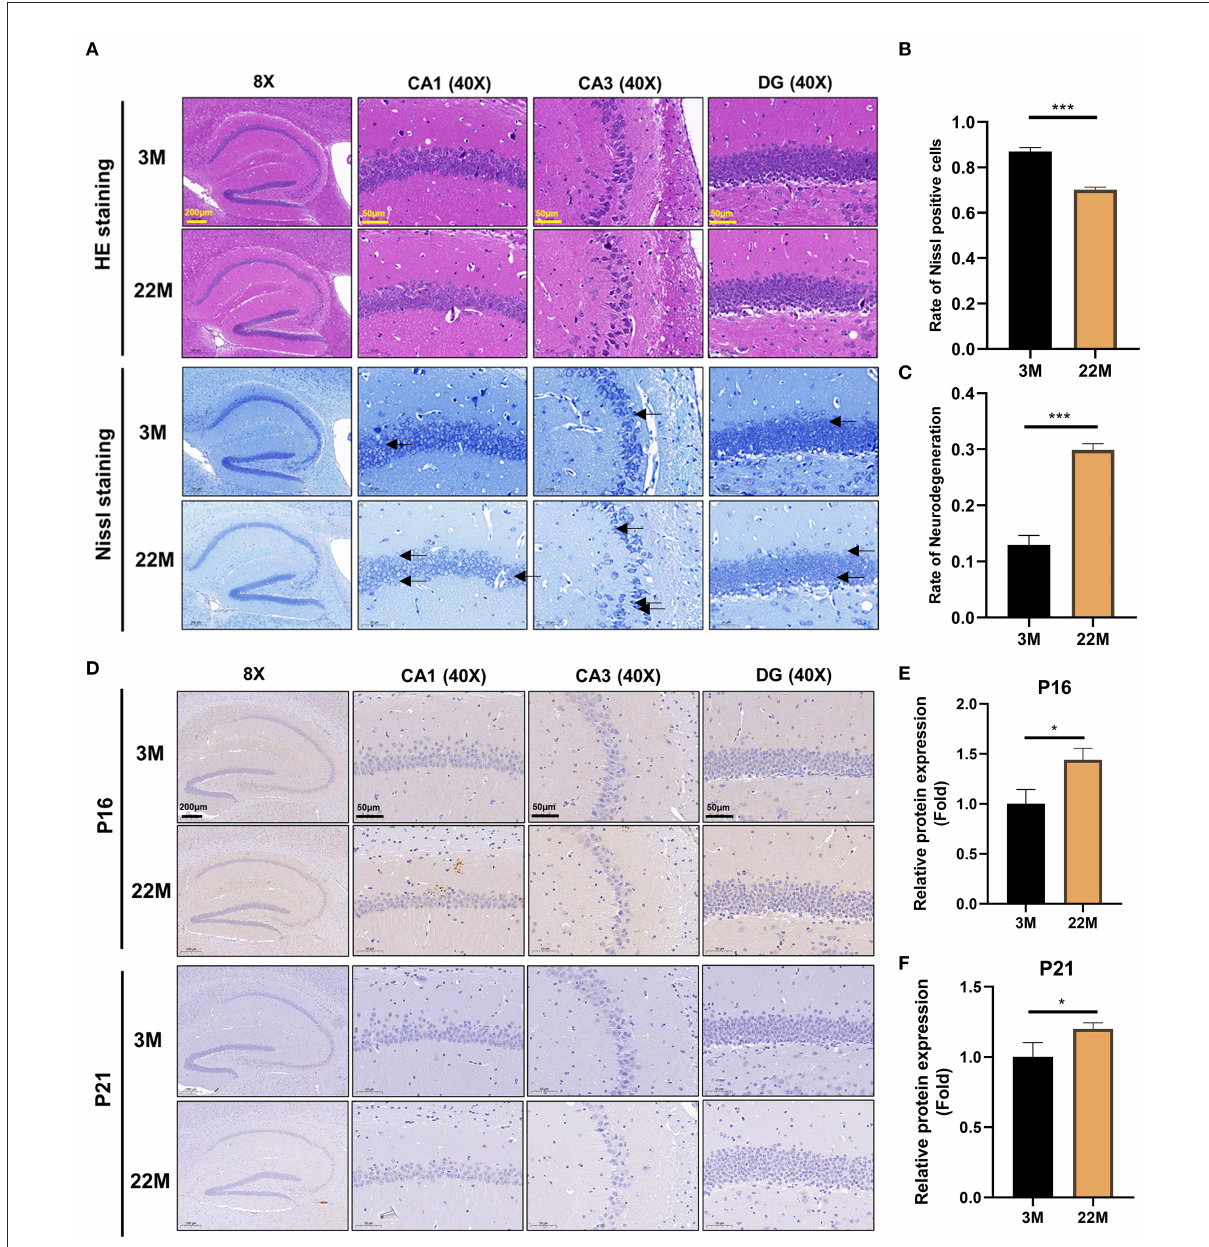
FIGURE2 Evaluation of hippocampal histomorphology in aging mice. (A) H&E and Nissl staining in the hippocampus between 3M and 22M group. The magnifications and scale bars were shown in (A) . (B,C) Nissl positive cells and Neurodegeneration rate in the hippocampus were assessed by Nissl staining. Data were represented as mean ± SD and were analyzed by Student t -test. *** P < 0.001. Arrows showed degenerated neurons. (D) IHC of senescence markers P16 and P21 in the hippocampus. The magnifications and scale bars were shown in (D) . (E,F) Relative expressions of senescence markers P16 and P21 were calculated by IHC. Data were represented as mean ± SD and were analyzed by Student t -test. * P <